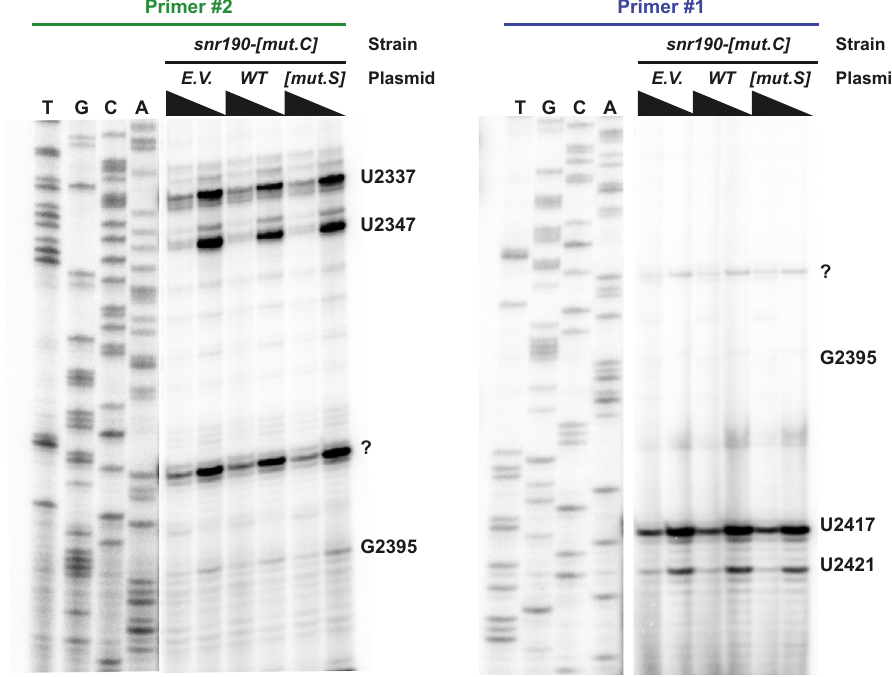
Fig. 3 snR190 does not function as a methylation guide. Reverse transcription experiment at normal or low dNTP concentration (black triangles) using total RNA extracted from strain BY4741 snr190-[mut.C] transformed with plasmids expressing the wild-type ( WT ) or snr190-[mut.S] versions of snR190 or the empty vector ( E.V .) as control. Two different primers were used to initiate reverse transcription: primer #2 (proximal, green) and primer #1 (distal, blue). A sequencing ladder was loaded in parallel to identify the nucleosides inducing reverse transcription stops. Note: a weak reverse transcription stop was observed at position G2395 with the proximal primer, but this signal was detected both in the presence or absence of snR190, suggesting that it may correspond to a nonspeci fi c signal rather than a bona fi de methylation-induced reverse transcription stop. The question mark (?) indicates a strong reverse transcription stop that is not associated to currently known nucleoside methylation. These experiments were repeated two times independently with each primer and similar results were